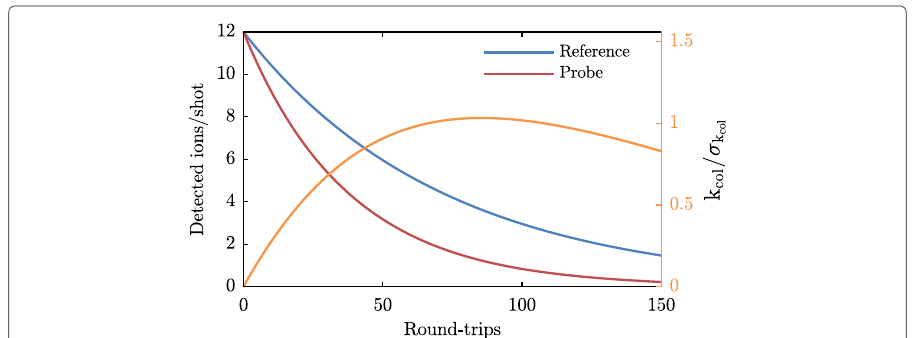
Fig. 2 Model of the probe (red) and reference (blue) signals (using numbers from the experiment discussed in Van der Poel et al. [32]), and the signal-to-noise ratio (orange, right y-axis) that results when these signals are used to calculate the loss rate due to collisions k col of the probe